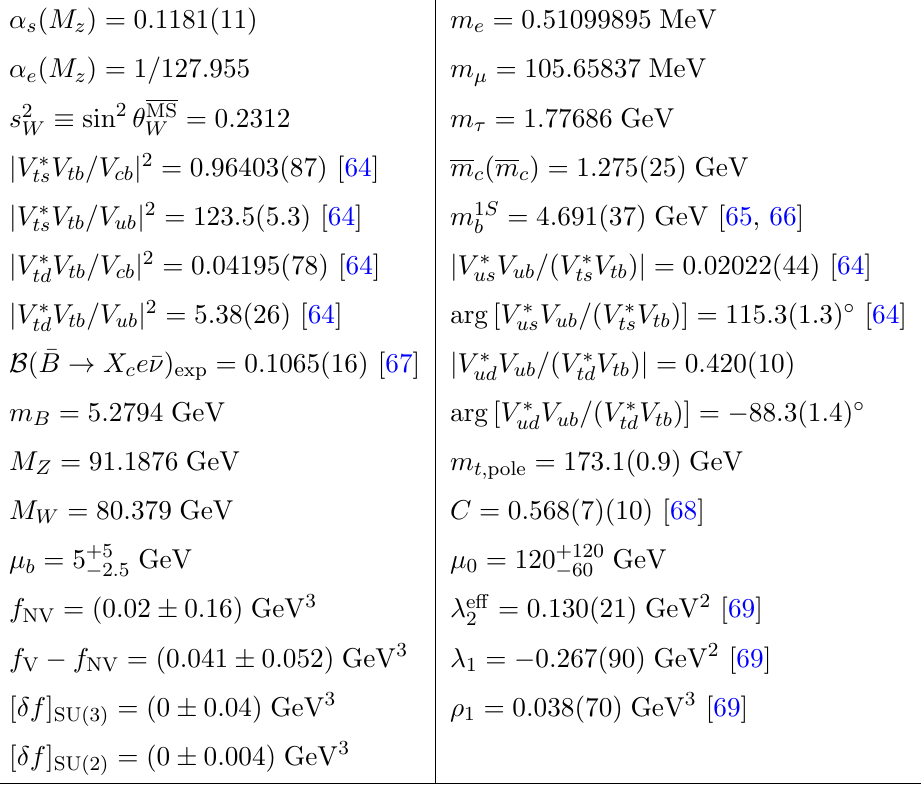
Table 1 . Numerical inputs used in the phenomenological analysis as in [50], taken from PDG [70] and CKM(cid:12)tter Group